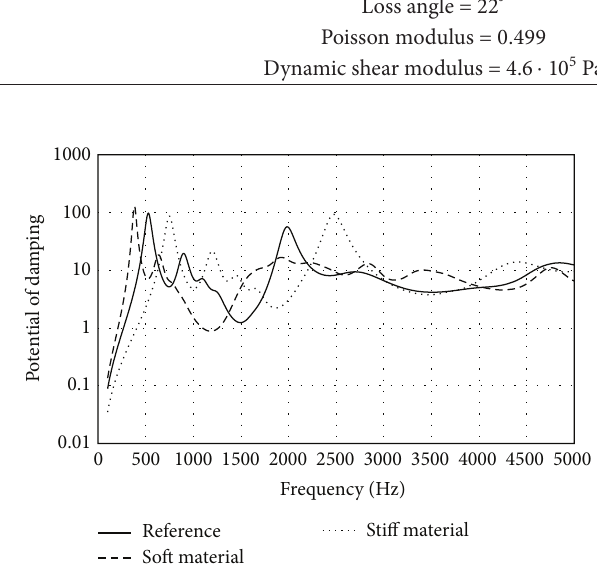
Figure3:Dampingpotentialforviscoelasticmaterialswithdifferent stiffness